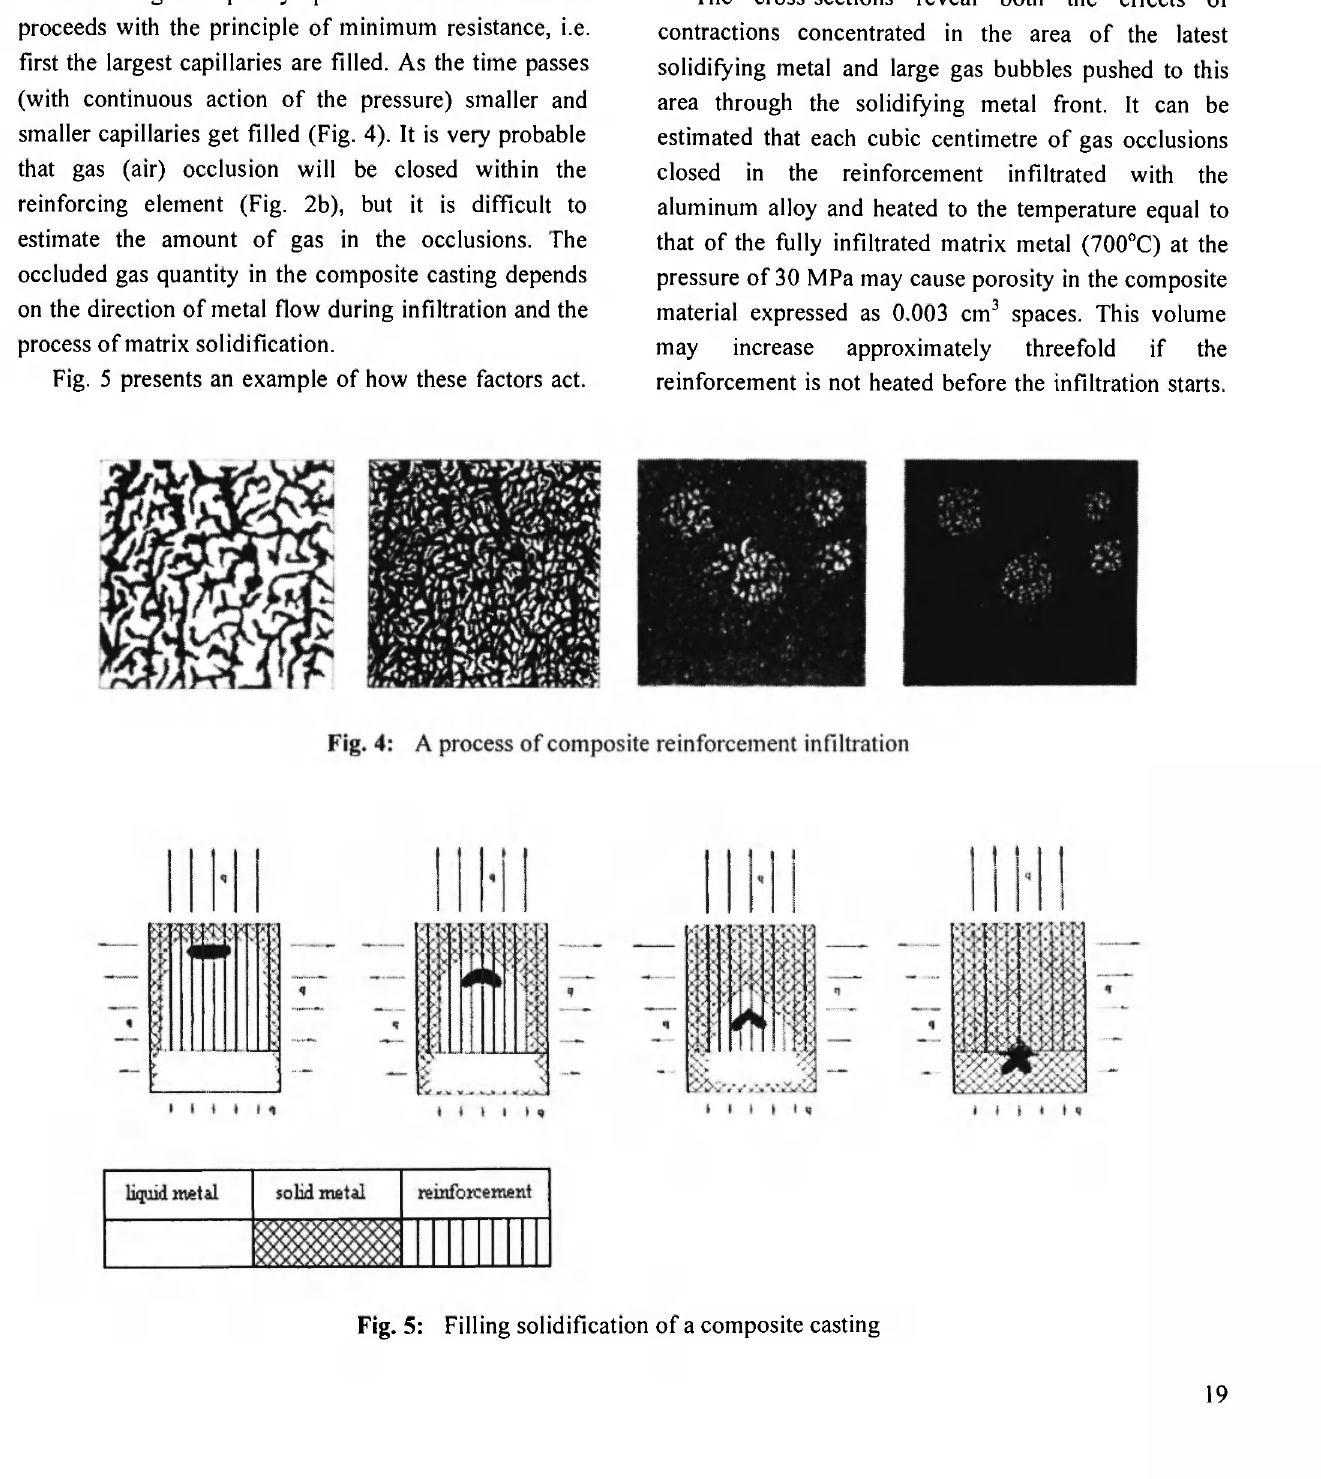
Fig. 5: Filling solidification of a composite